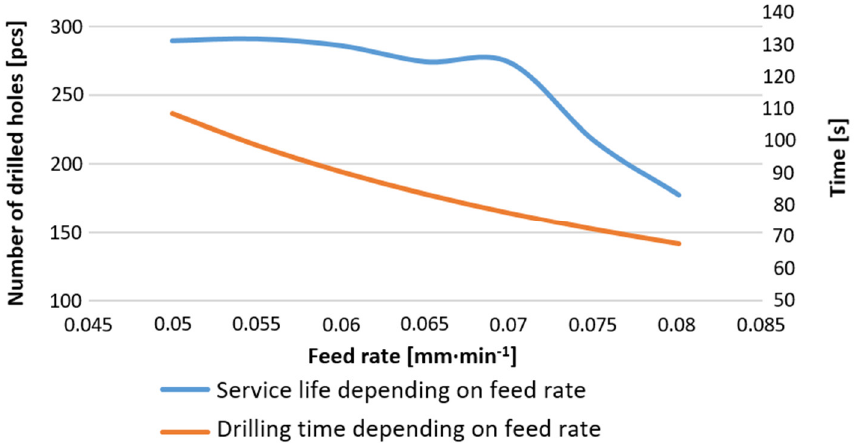
Figure 9. Dependence of the number of drilled holes up to the moment of tool damage and the operation’s duration on the change in feed rate.